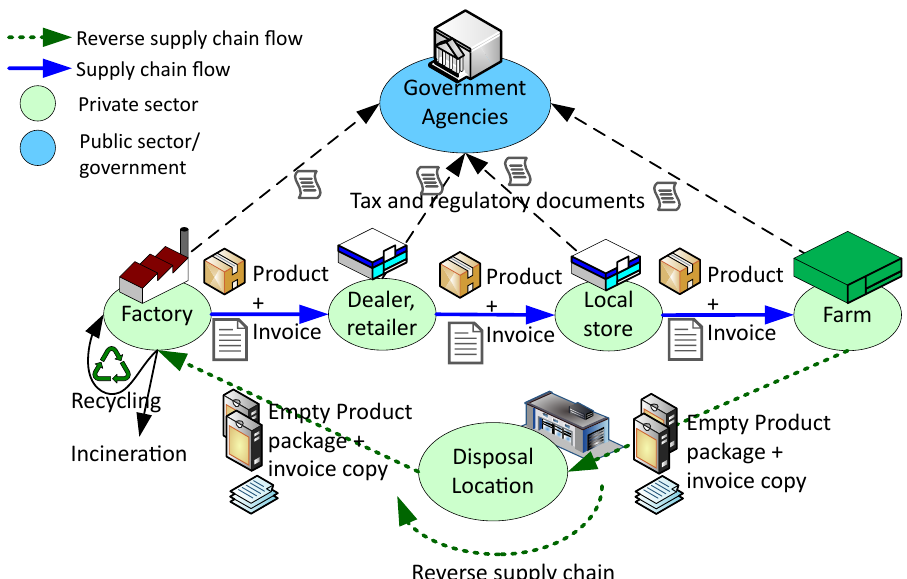
Figure 2. Reverse agrochemical supply